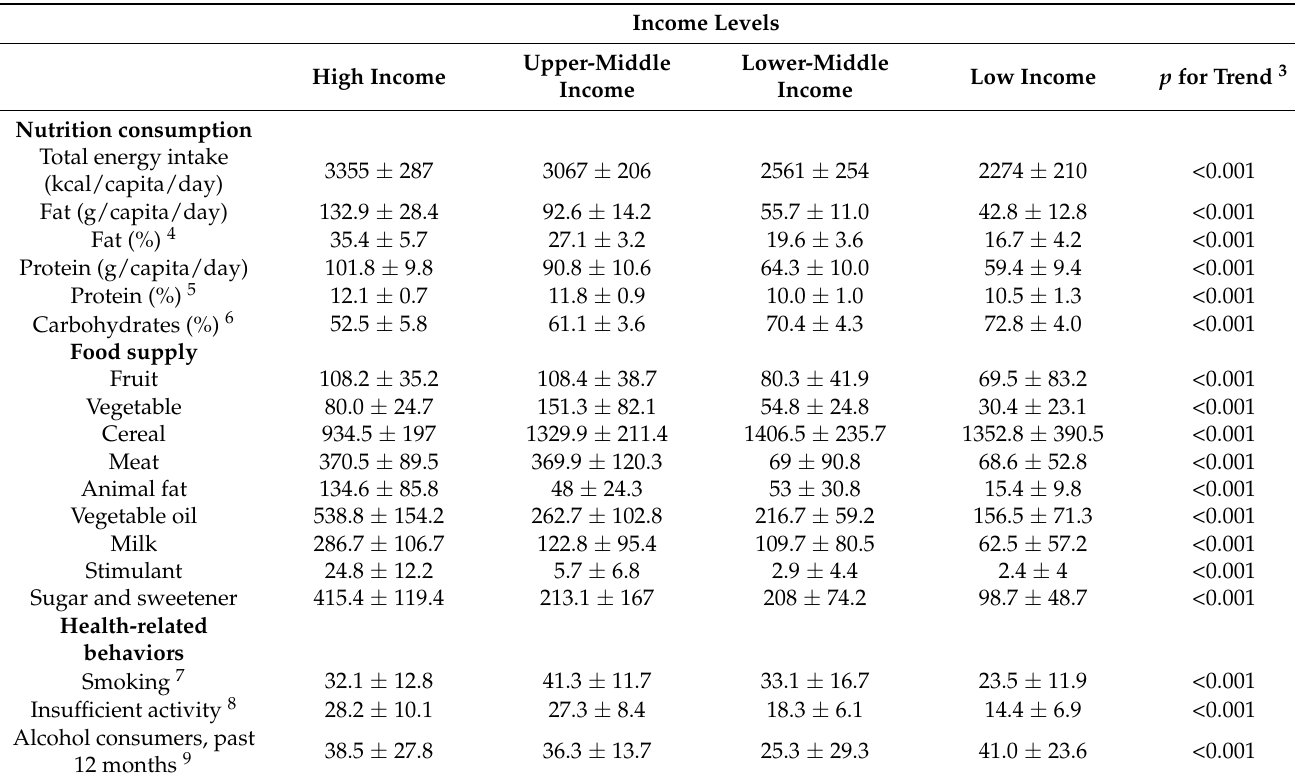
Table 2. Nutrition compositions, food supply, and health-related behaviors according to income level, including total energy intake, fat content, and protein content 1,2